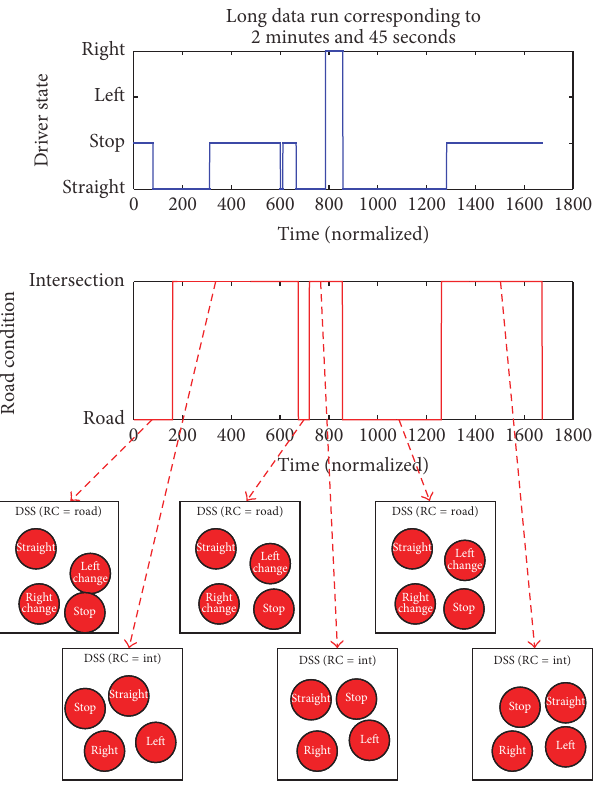
Figure 8: Metastate modification in conjunction used for observa- tion sequence of length of 2.75 minutes. For varying road conditions (middle plot) metastates contained in DSS are shown in lowest part of figure.